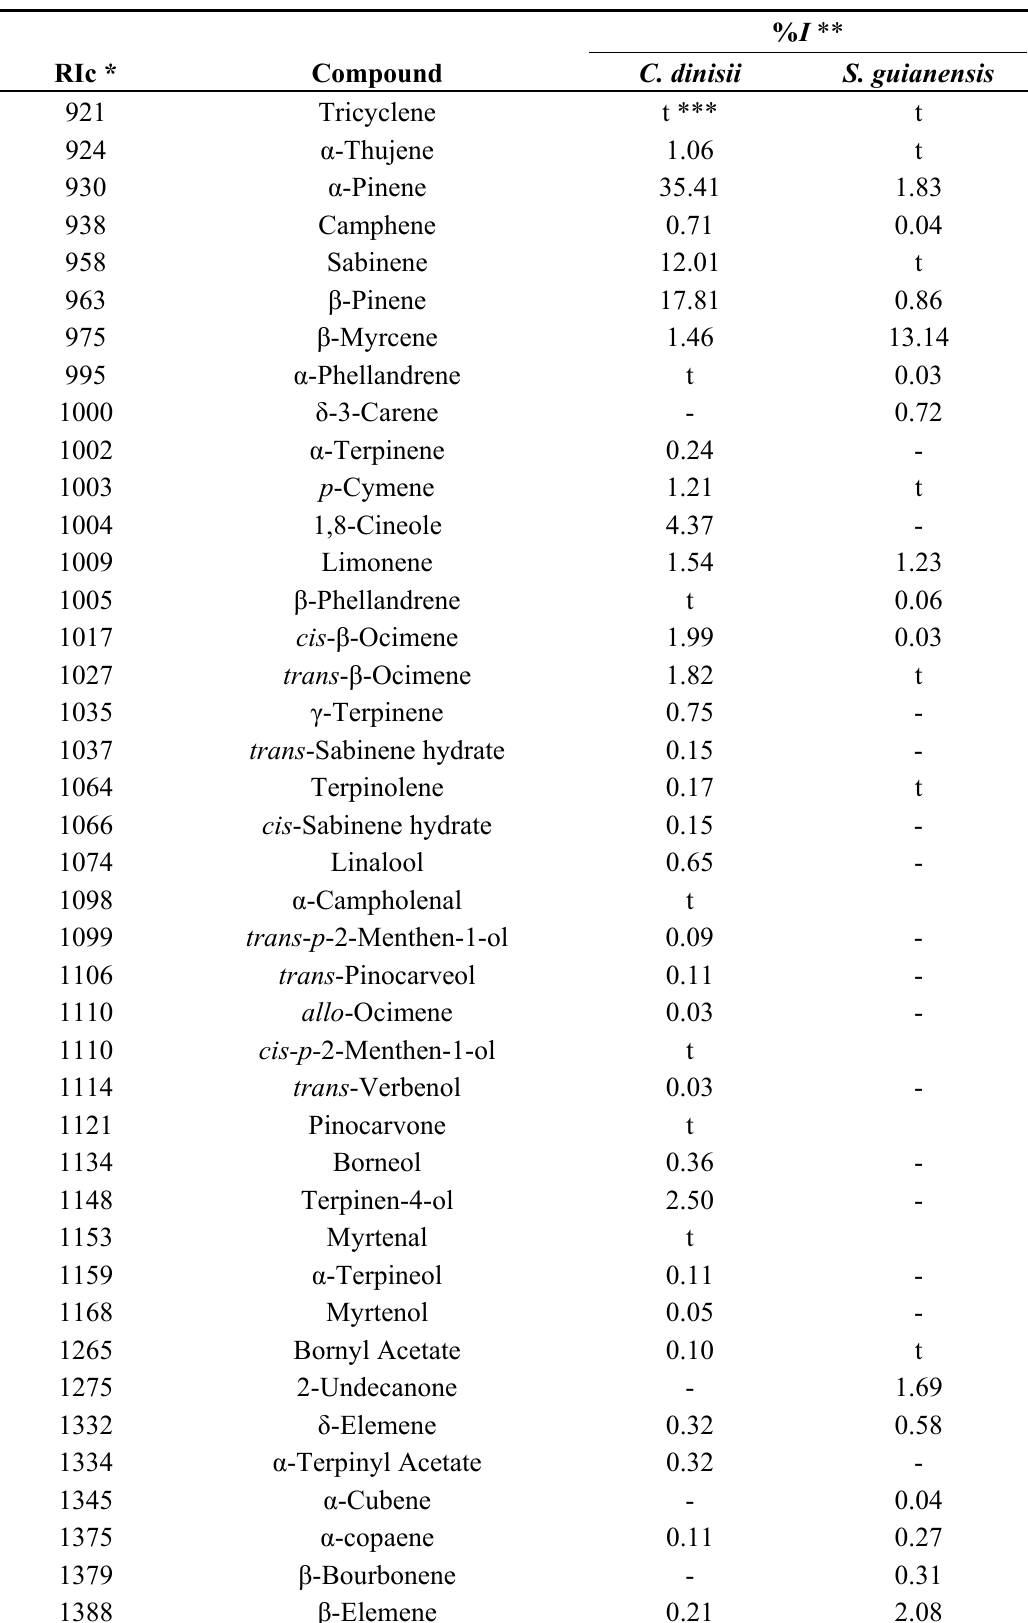
Table 1. Chemical composition of the essential oil of fresh leaves of Cinnamodendron dinisii and Siparuna